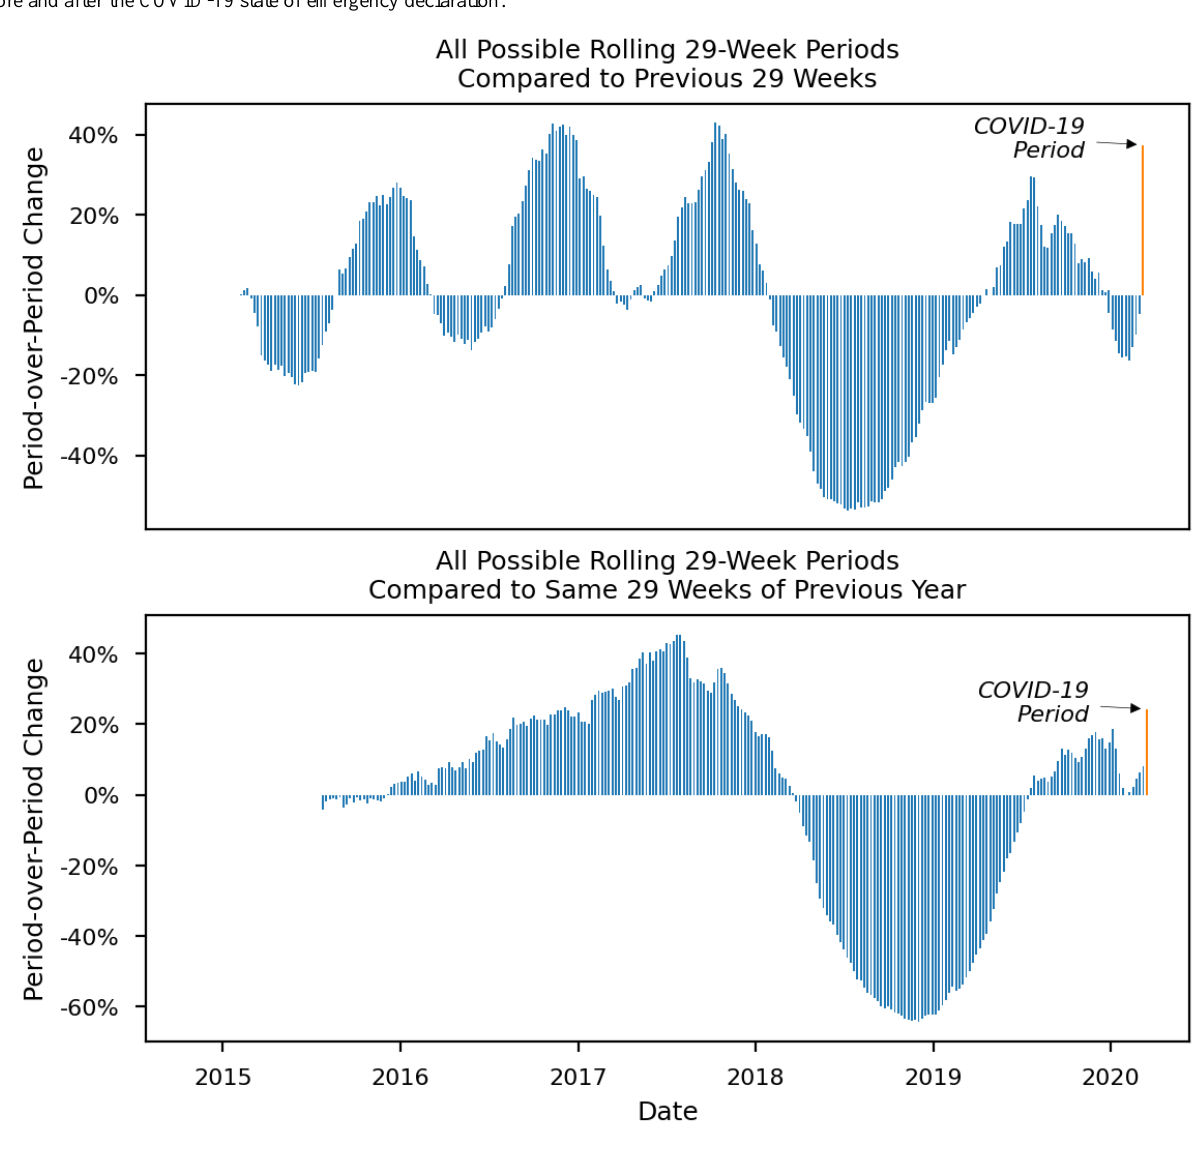
Figure 2. Historical period-over-period change in emergency medical services runs involving opioid overdoses in Guilford County, North Carolina before and after the COVID-19 state of emergency